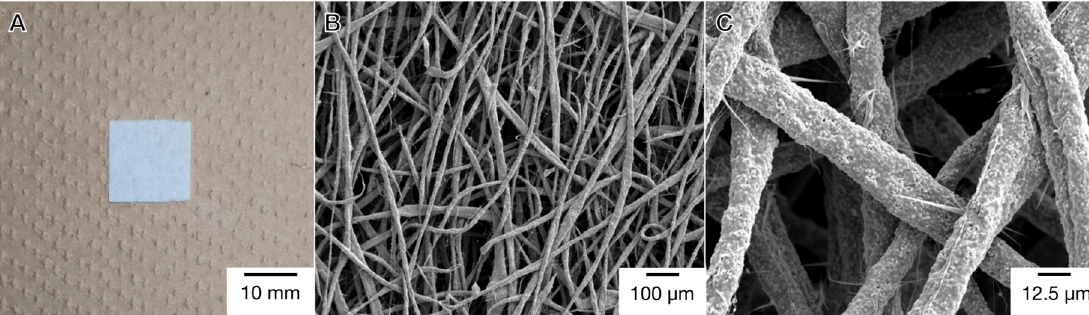
Figure 1. Light photomicrograph ( A ) and SEM images ( B , C ) of a microfiber mesh scaffold. Bars indicate 10 mm ( A ), 100 μ m ( B ), and 12.5 μ m ( C ). 10 mm ( A ), 100 µ m ( B ), and 12.5 µ m ( C